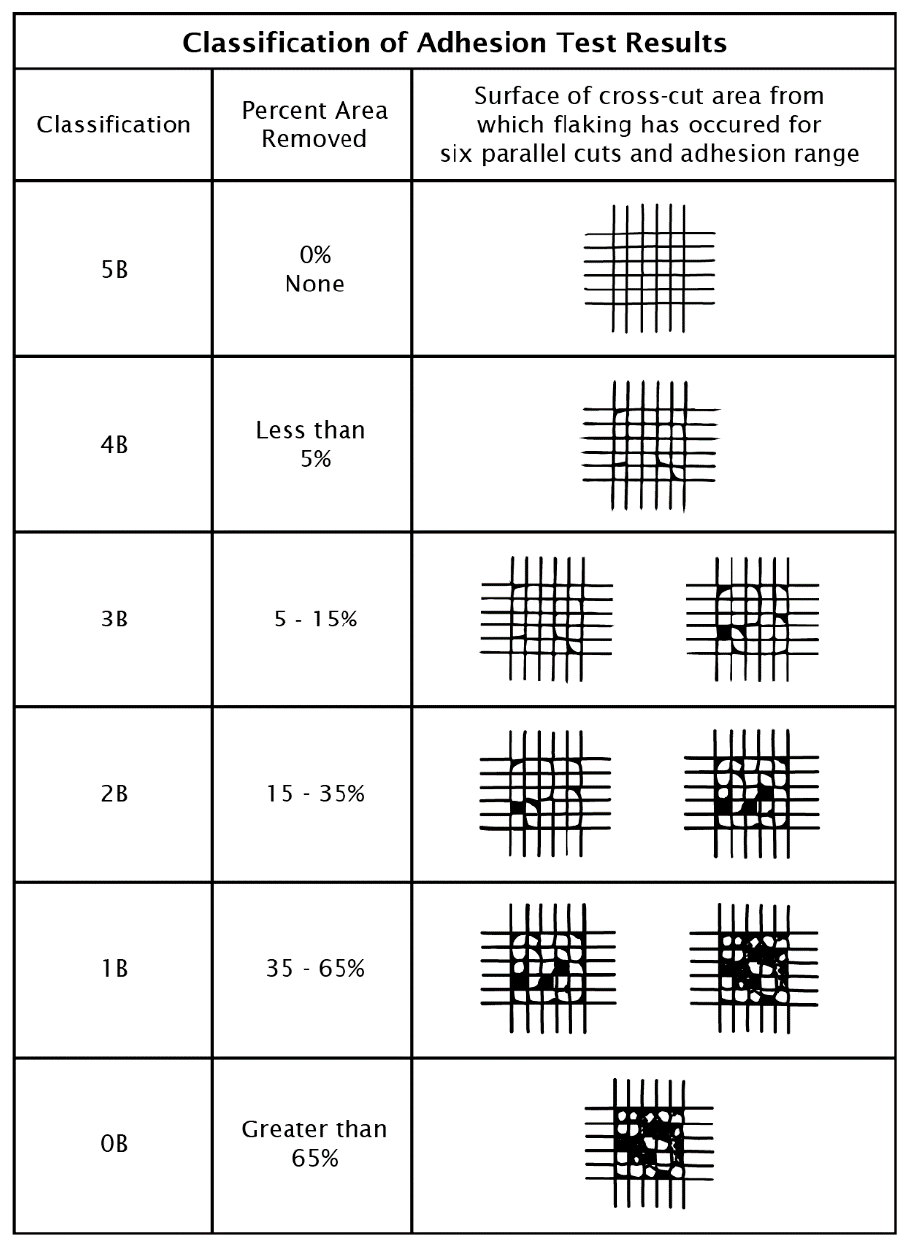
Figure A4. Classification of the different adhesion levels as a result of the cross-cut test.